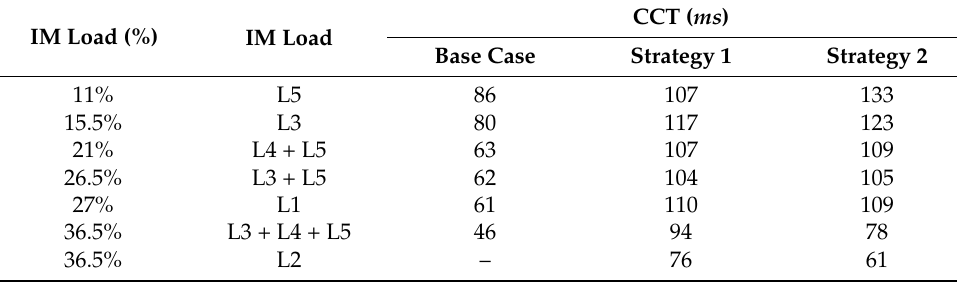
Table 8. Network fault critical clearance time vs. motor load